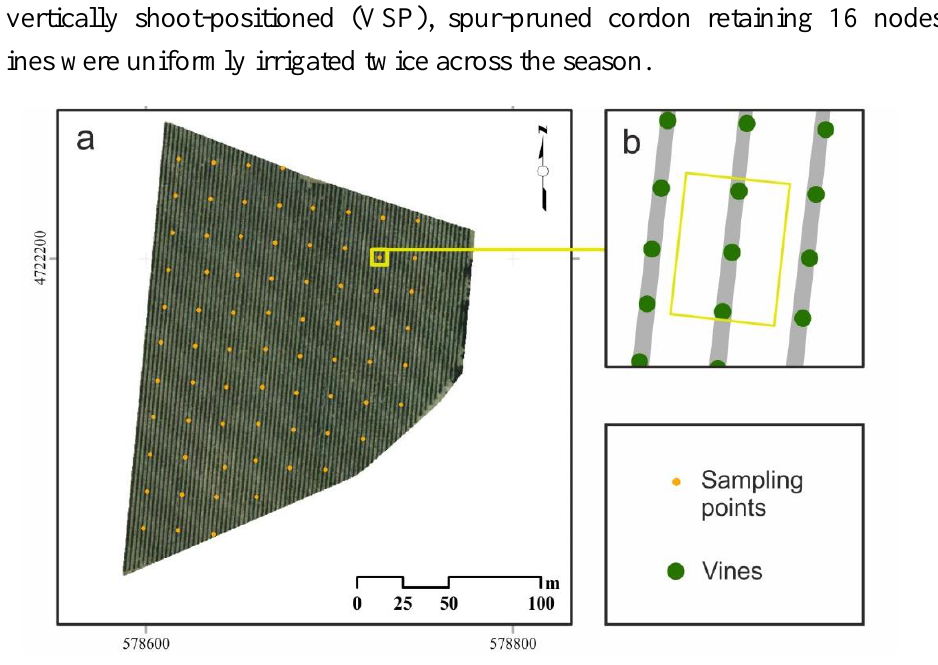
Figure 1. Experimental Tempranillo vineyard plot with the 72 sampling points ( a ). Schematic describing the position of the three adjacent vines comprising a sampling point ( b